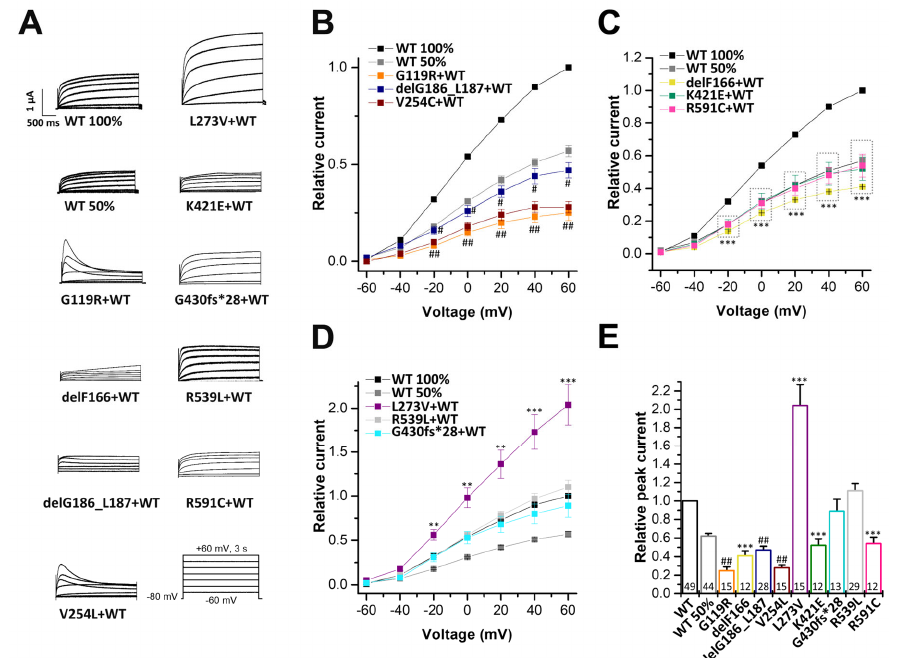
Figure 4. Electrophysiological characterization of the KCNQ1 variants co-expressed with wild- type KCNQ1 channels. ( A ) KCNQ1 wild-type (14.5 ng cRNA/oocyte, WT 100%), KCNQ1 wild- type (7.25 ng cRNA/oocyte, WT 50%) or KCNQ1 wild-type (7.25 ng cRNA), plus KCNQ1 mutant (7.25 ng/oocyte) were expressed in Xenopus laevis oocytes. In voltage-clamp recordings, voltage was stepped to potentials between − 60 and +60 mv in 20 mV-steps lasting 3 s, starting from a holding potential of − 80 mV (voltage protocol illustrated at the bottom). Representative current traces for wild-type KCNQ1 (WT 100%), KCNQ1 WT 50% or KCNQ1 WT co-expressed with the indicated variants are shown. ( B ) Current-voltage relationships obtained by plotting the current at the end of each voltage step, normalized to the current of KCNQ1 wild-type 100%. In order to obtain the current-voltage relationship (I/V curve), all wild-type recordings were normalized to the value at +60 mV. The data of all the other constructs were also divided by the average current amplitude of the wild-type, at +60 mV of the respective recording day. Illustrated are the dominant-negative variants with significantly reduced current amplitudes compared to KCNQ1 wild-type 50% (marked with # or ##), ( C ) KCNQ1 variants with significantly reduced current amplitudes compared to KCNQ1 WT 100% (marked with ***), and ( D ) KCNQ1 variants with unchanged current amplitudes or even significantly increased current amplitudes compared to KCNQ1 WT 100% (marked with ** or ***). ( E ) Current amplitudes analyzed at +40 mV and normalized to the currents of wild-type KCNQ1 channels. All the data, including that of the wild-type recordings, were divided by the average current amplitude of the wild-type at +40 mV of the respective recording day. Numbers of oocytes recorded are indicated within the bar graphs. Values are expressed as means ± S.E.M.. Error bars represent S.E.M. values. Significance was assessed using two-tailed Student’s t -test. Asterisks indicate significance compared to wild-type KCNQ1 100%: **, p < 0.01; ***, p < 0.001 or to KCNQ1 wild-type 50%: #, p < 0.05 or ##, and p <